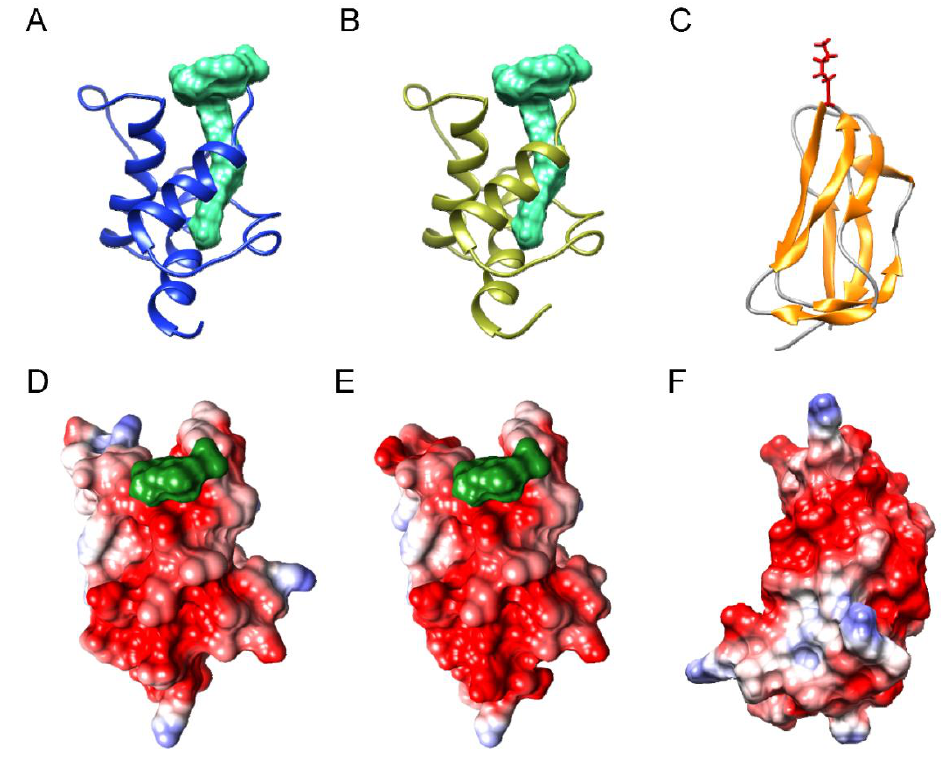
Figure 8. Proposed structural models for Arabidopsis acyl-carrier protein ACP1 ( A and D ), ACP2 ( B and E ), and plastid E2 subunit of pyruvate dehydrogenase LTA2 ( C and F ), based on those of Spinacia oleracea acyl-ACP (Protein Data Bank accession 2fva) [22] and human pyruvate dehydrogenase complex (Protein Data Bank accession 1y8n) [23]. Panels ( A , B , and C ) are ribbon diagrams in which the acyl chains are shown in green ( A and B ) and lysine residue in red ( C ). Panels ( D , E , and F ) are views of the molecular surfaces showing the electrostatic potentials according to Coulomb’s laws with extensive negatively charged patches near the acyl chain insertion (in acyl-ACPs, panels D and E ) or the lysine residue (in LTA2).